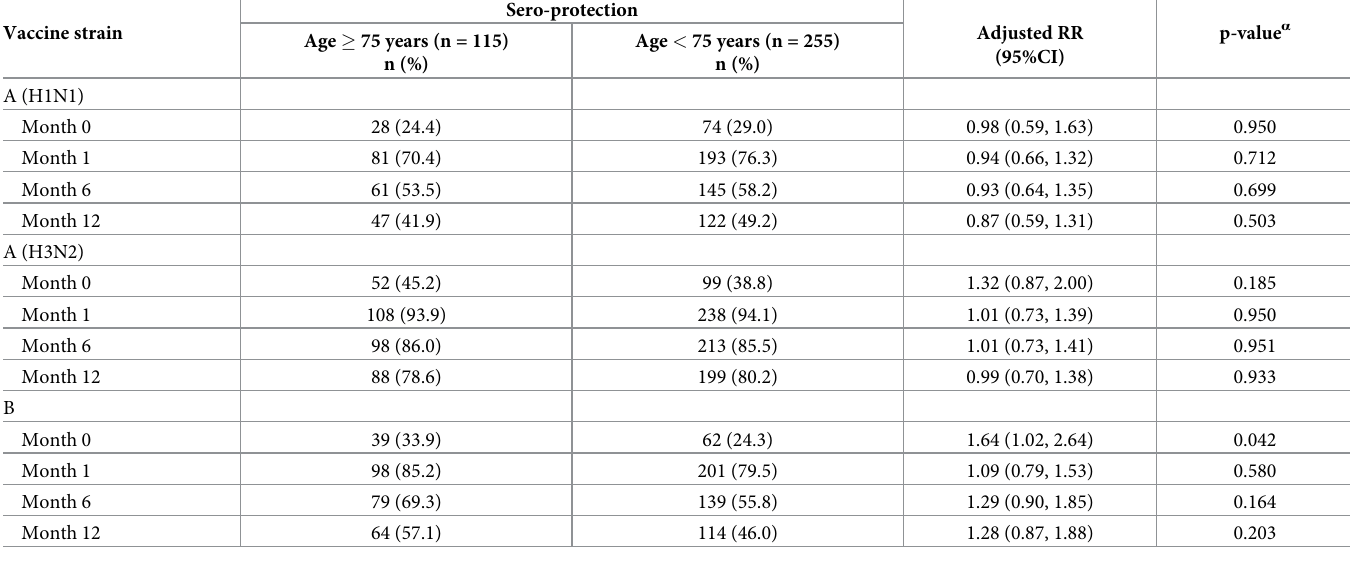
RR = relative risk. CI = confidence interval α Log-binomial regression adjusted for age group sex. Significance level at <